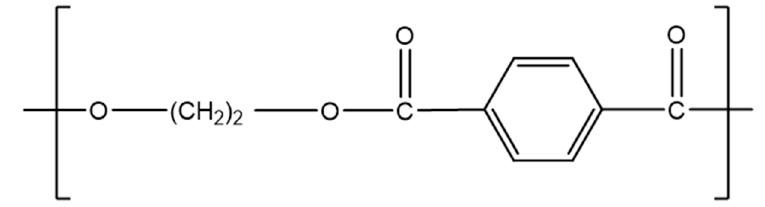
Figure 13. PET unit. Reproduced with permission [118].